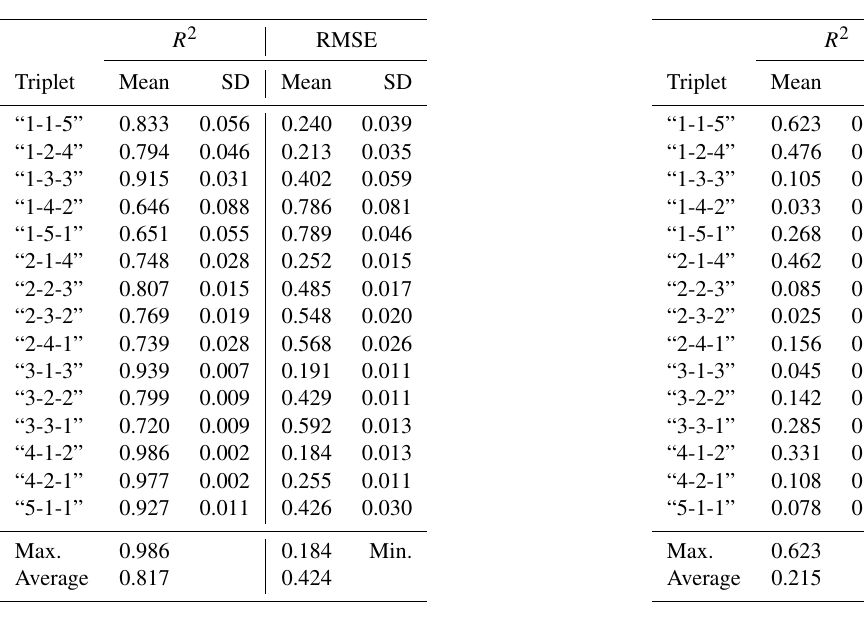
Table 4. R 2 and RMSE (ln (cmh − 1 )) values for linear regressions of IE vs. ln K sat using the 15 different triplets for the SC1 selection.